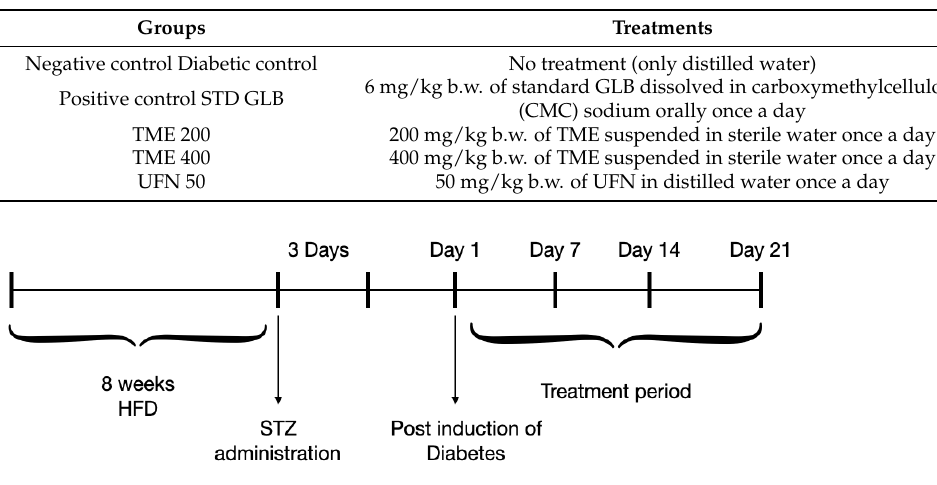
Table 3. Groups and their respective treatments.